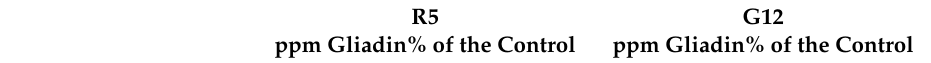
Table 4. The alteration of the immune reactive R5 and G12 peptides caused by the different abi- otic